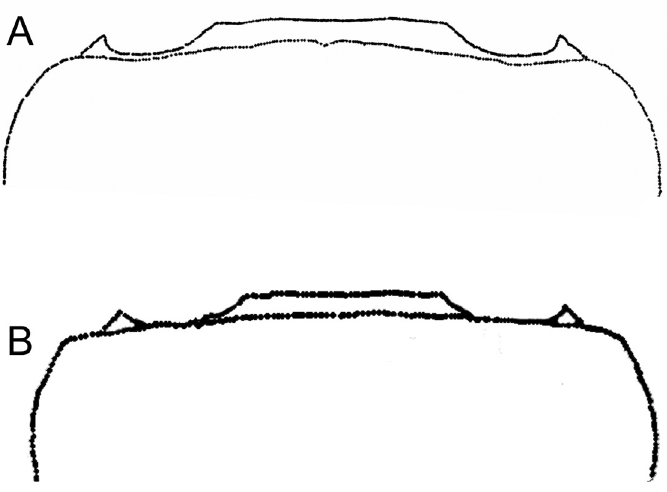
Figure 9. Morphological comparison of carapace features between A P. perlatus and B P. danielsi sp.